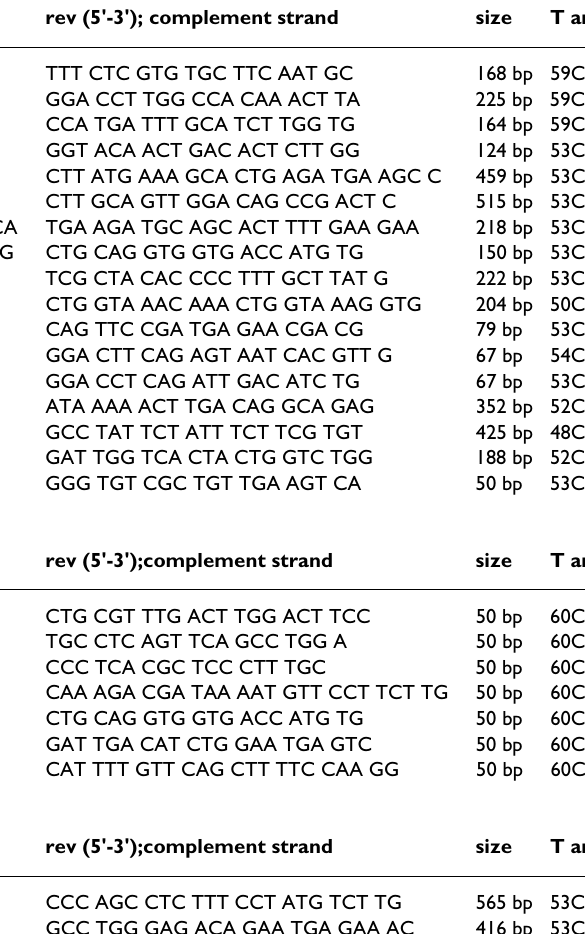
Table 1: Primers and conditions for PCR RT-PCR